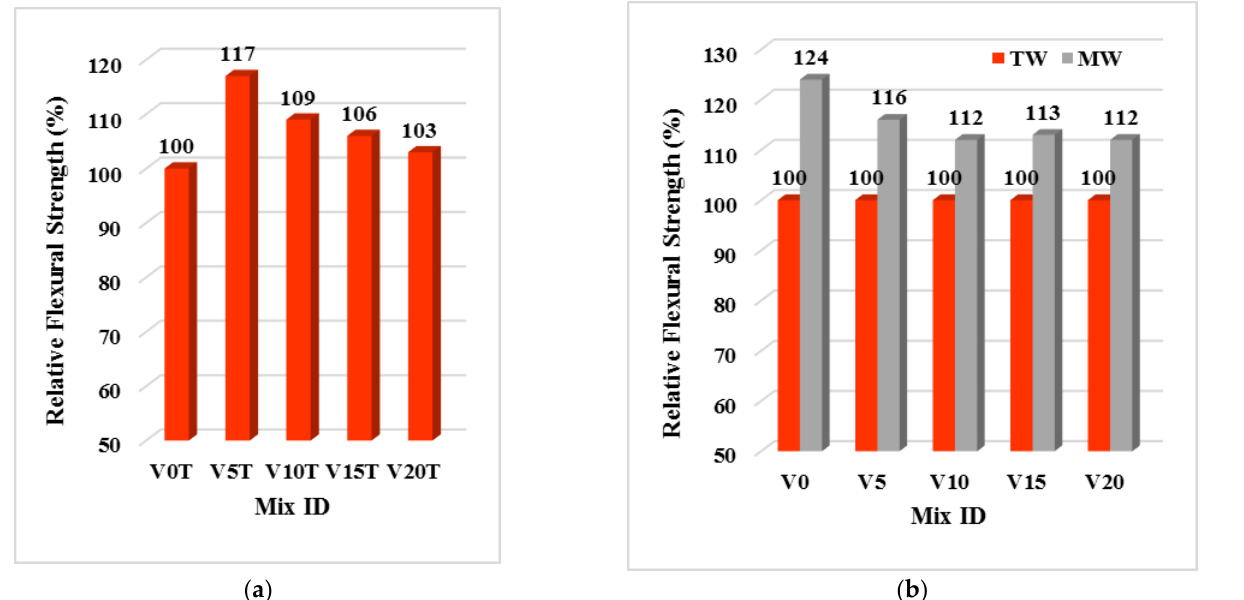
Figure 13. Volcanic concrete splitting tensile strength: ( a ) effect of VA and ( b ) effect of MW.